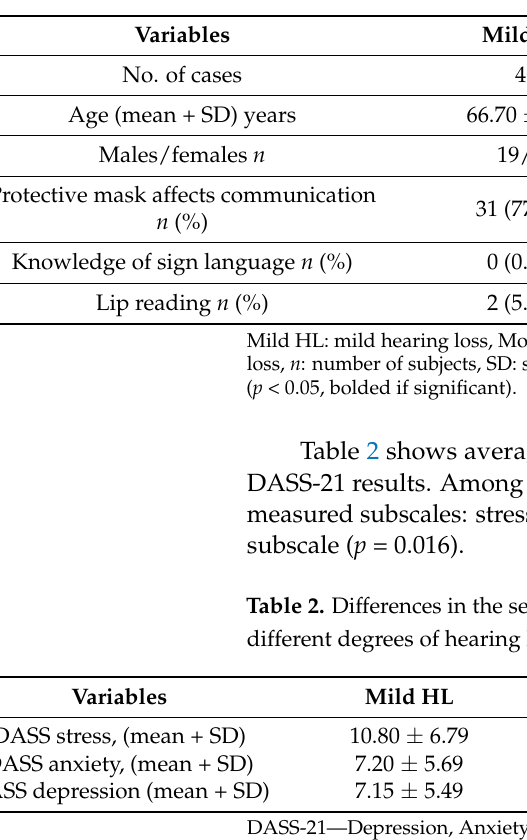
Table 1. Socio-demographic characteristics of patients in relation to the degree of hearing loss.